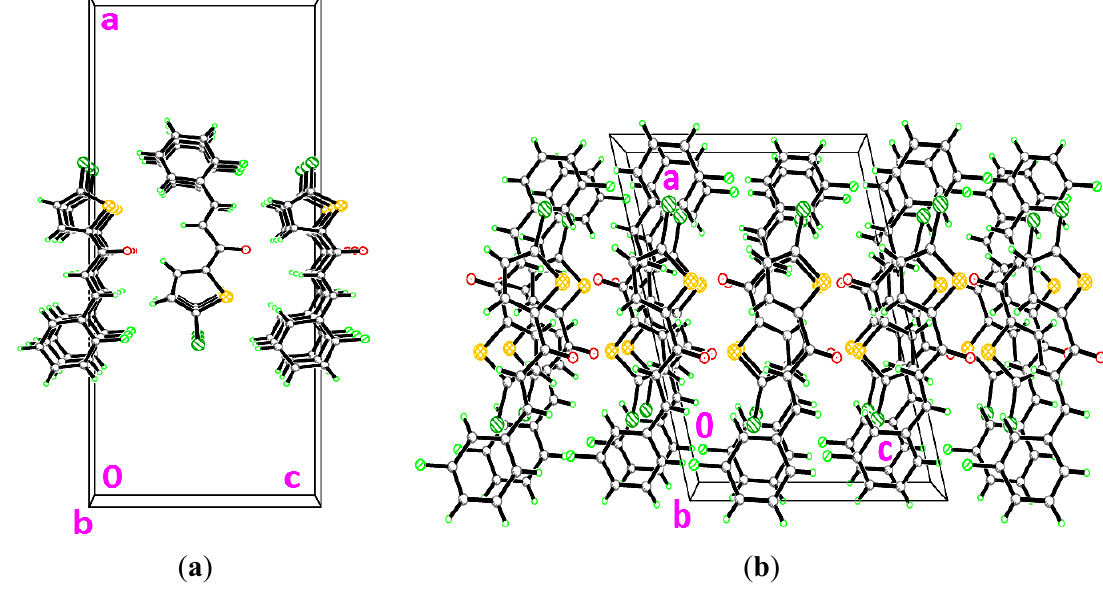
Figure 4. Crystal structures of ( a ) 3a and ( b ) 3b . The molecules are stacked along the b -axis.